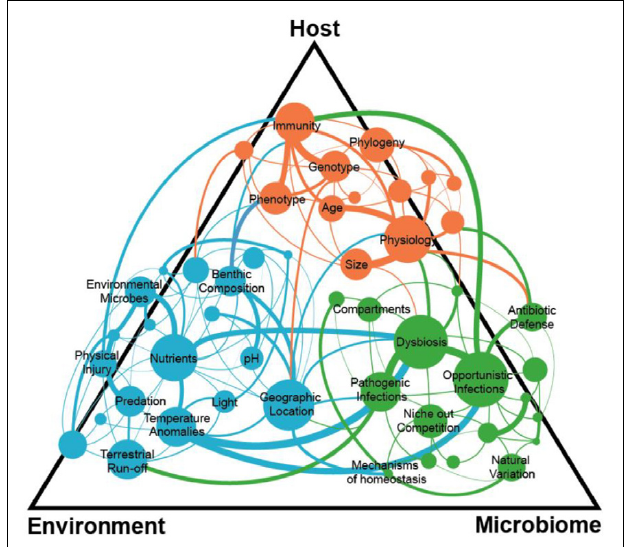
FIGURE 2 | Complex interactions within and among the coral host, environment, and microbiome can lead to a disease state with many connections still